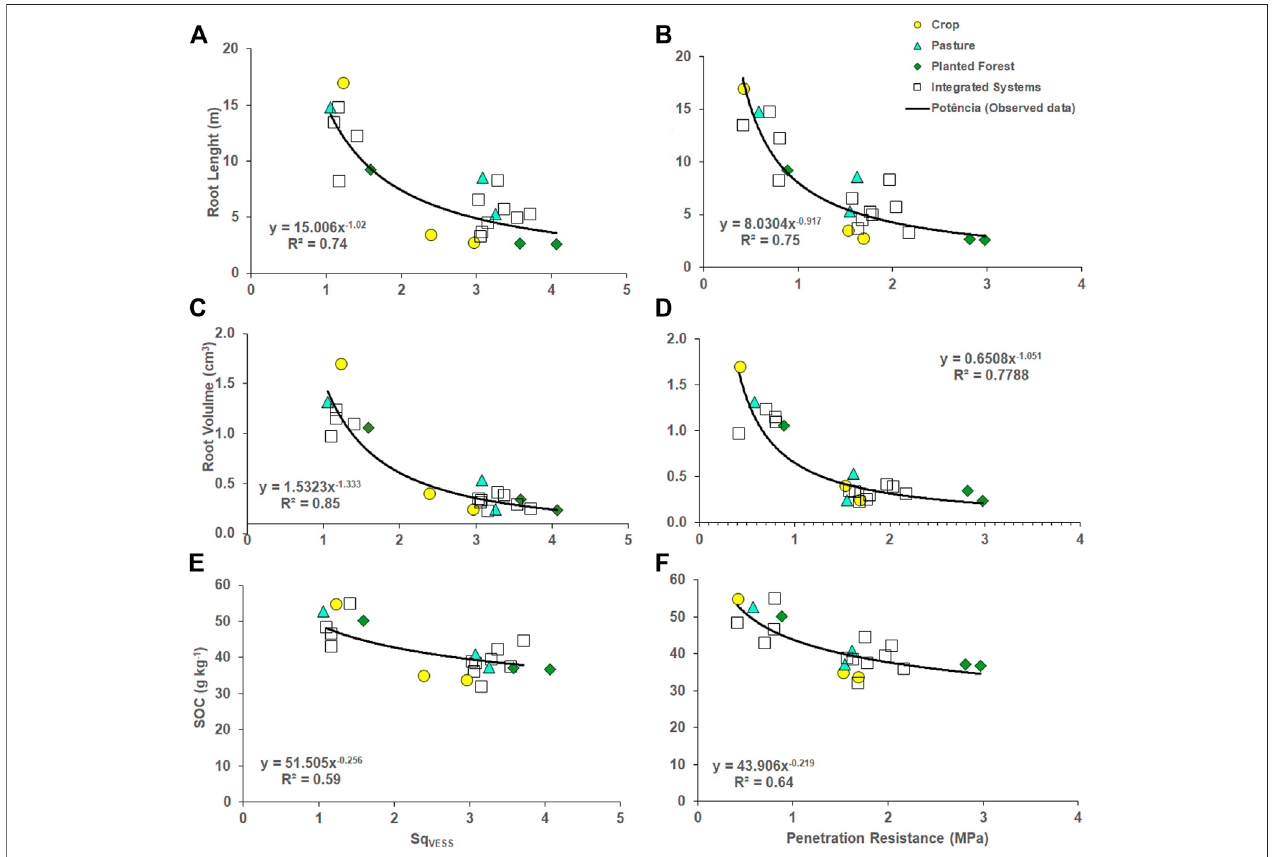
FIGURE 2 | Relationship between root properties (root length and root volume), and total organic carbon (SOC), respectively, with soil quality (Sq VESS ) from visual evaluation of soil structure and soil penetration resistance (PR).